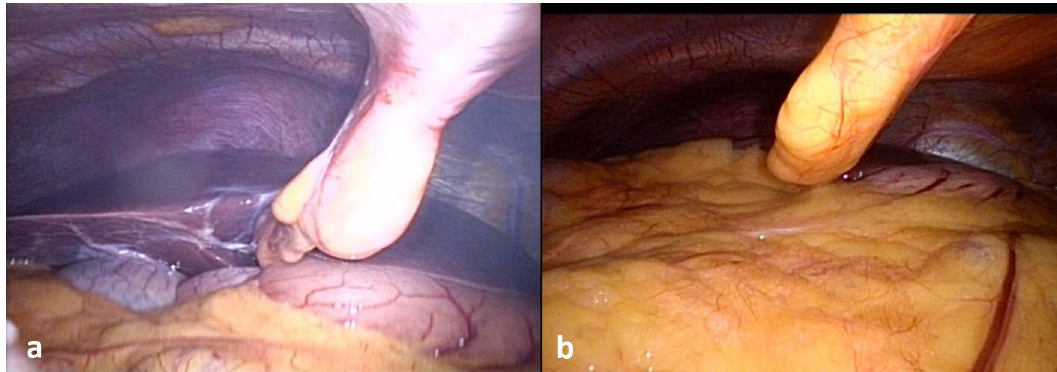
Figure 4. Upper abdominal imaging of two patients in the Trendelenburg position (30°). ( A ) 31Y, BMI = 19.3; ( B ) 32Y, BMI =